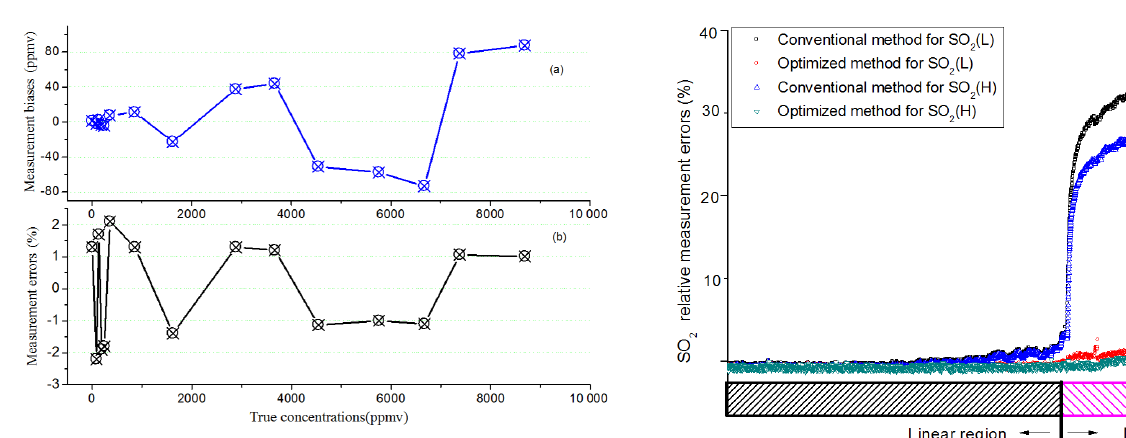
Figure 10. Comparison between the conventional and the optimized retrieval algorithm. H 2 O absorption varied gradually from linear re- gion to nonlinear